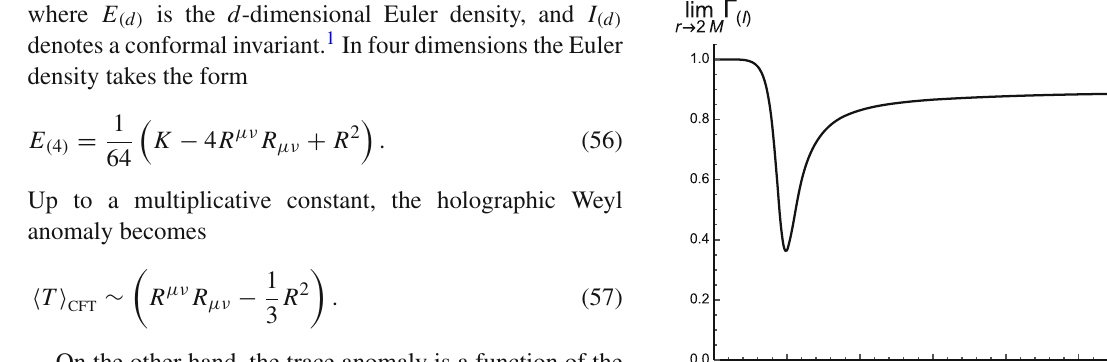
Notice that for large values of r , all three coefficients have near unit